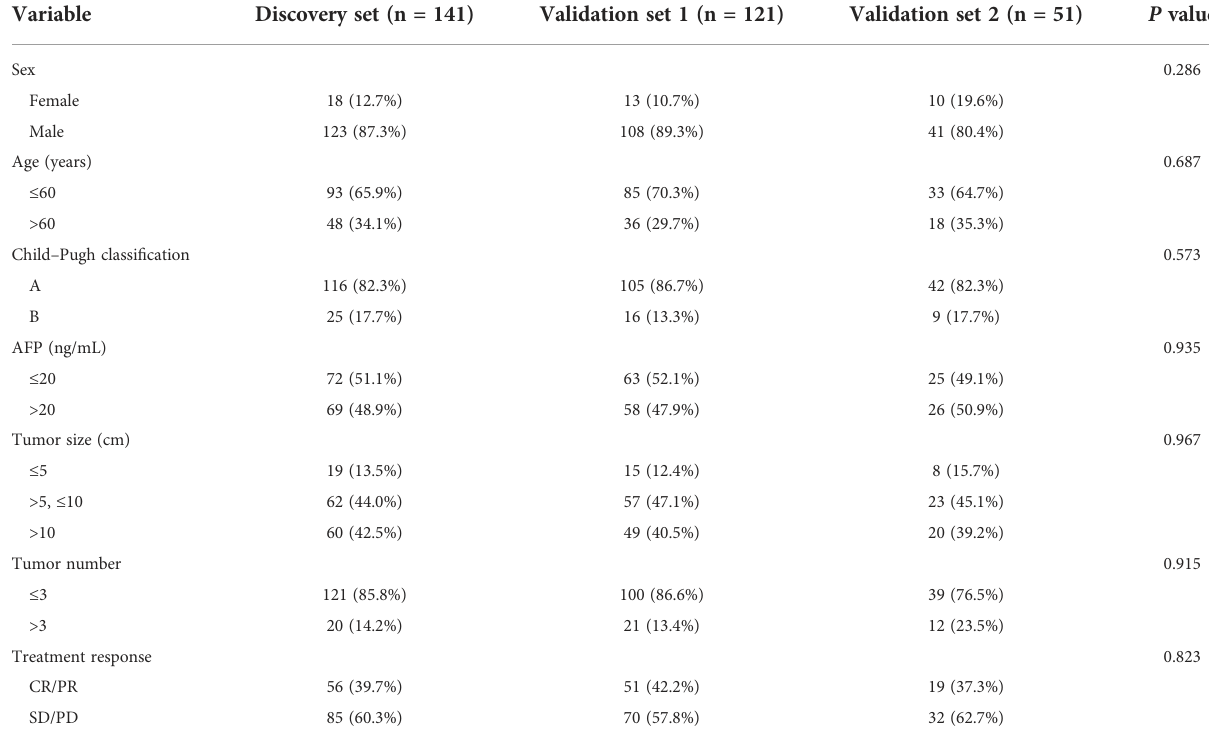
TABLE 1 Patient characteristics by study